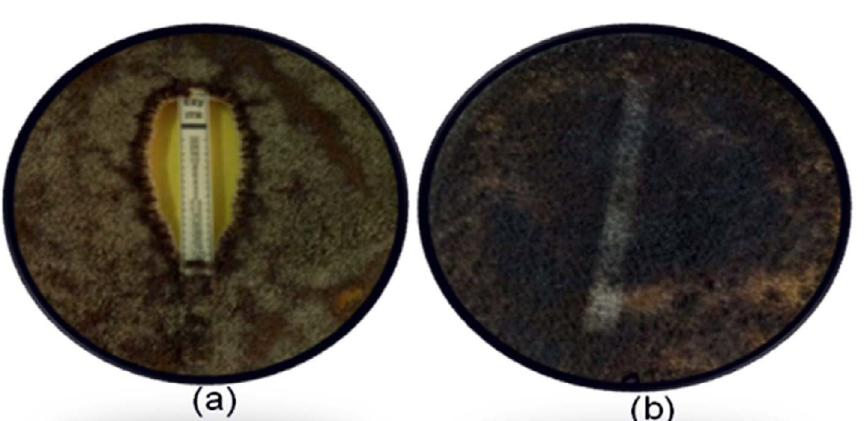
Fig. 2. E-strip result for susceptible and resistant strains. (a): Inhibition zone by itraconazole-strip against susceptible control strain, (b): no inhibition in resistant